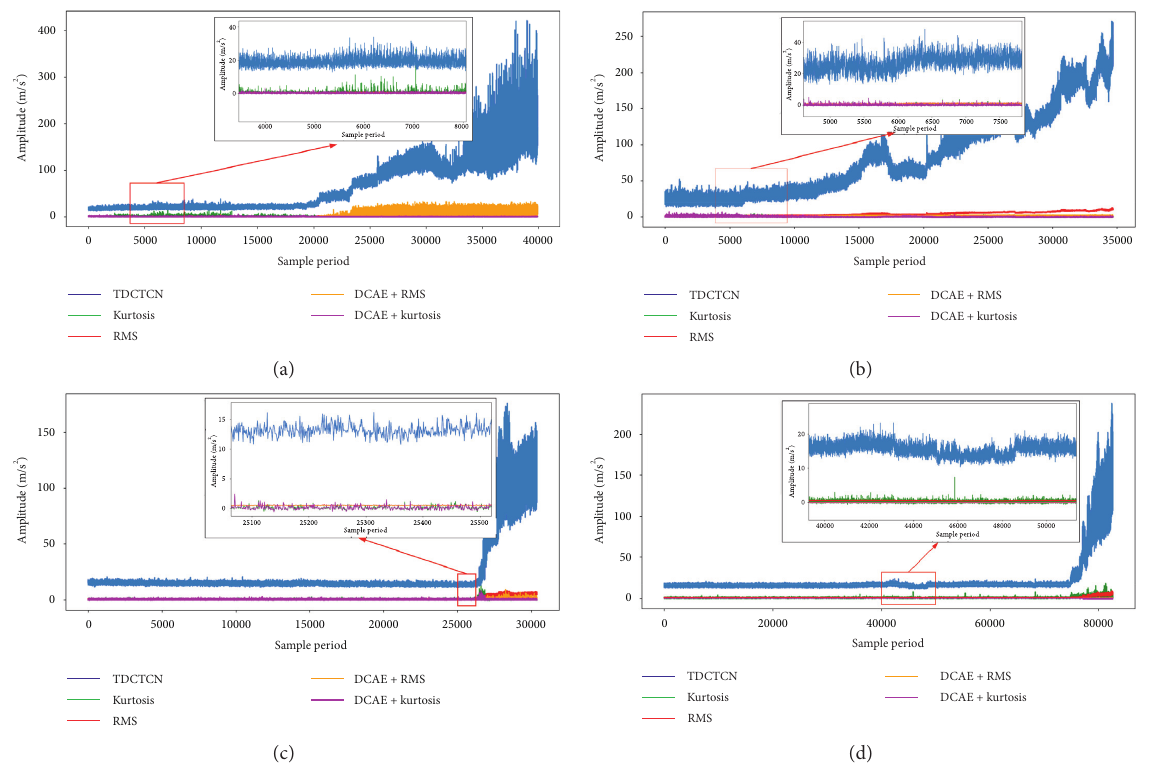
Figure 9: Description of the running state of rolling bearings. (a) Bearing2_3. (b) Bearing2_5. (c) Bearing3_3. (d) Figure 11 is a description of the operation status of rolling bearings in the target domain without transfer learning. Compared with Figure 8, Figure 11 is zoomed in in